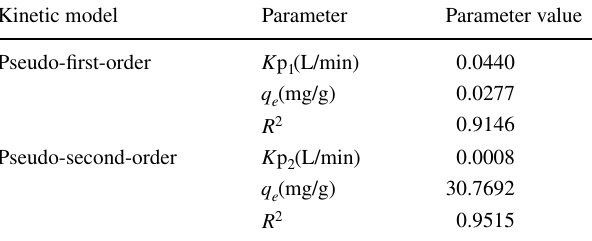
Table 2 Kinetic model constants and their correlation coefficients ( R 2 ) for Cd(II) removal by UMSFS biomass Kinetic